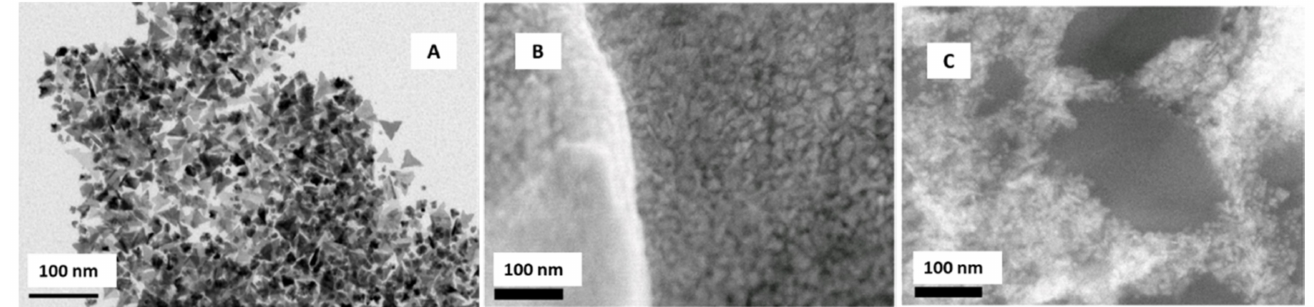
Figure 4. ( A ) TEM micrograph of Ru-NPLs obtained through the hydrothermal reduction of Ru salt by formaldehyde in the presence of PVP. SEM micrographs of Ru-NPLs in H 2 O, ( B ) in ethanol, ( C ) modified screen-printed graphene electrode. Reproduced with permission of Baradoke, Pastoriza-Santos y Gonz á lez-Romero, Electrochimica Acta; published by Elsevier, 2019